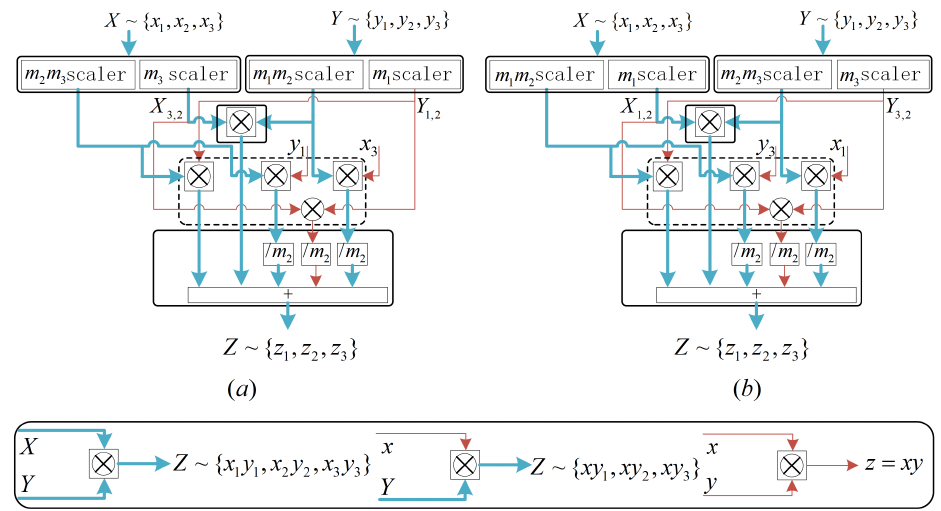
Figure 3. Compensatory scaling RNS multiplier structure. ( a ) multiplier structure corresponding to (29), ( b ) multiplier structure corresponding to (33).